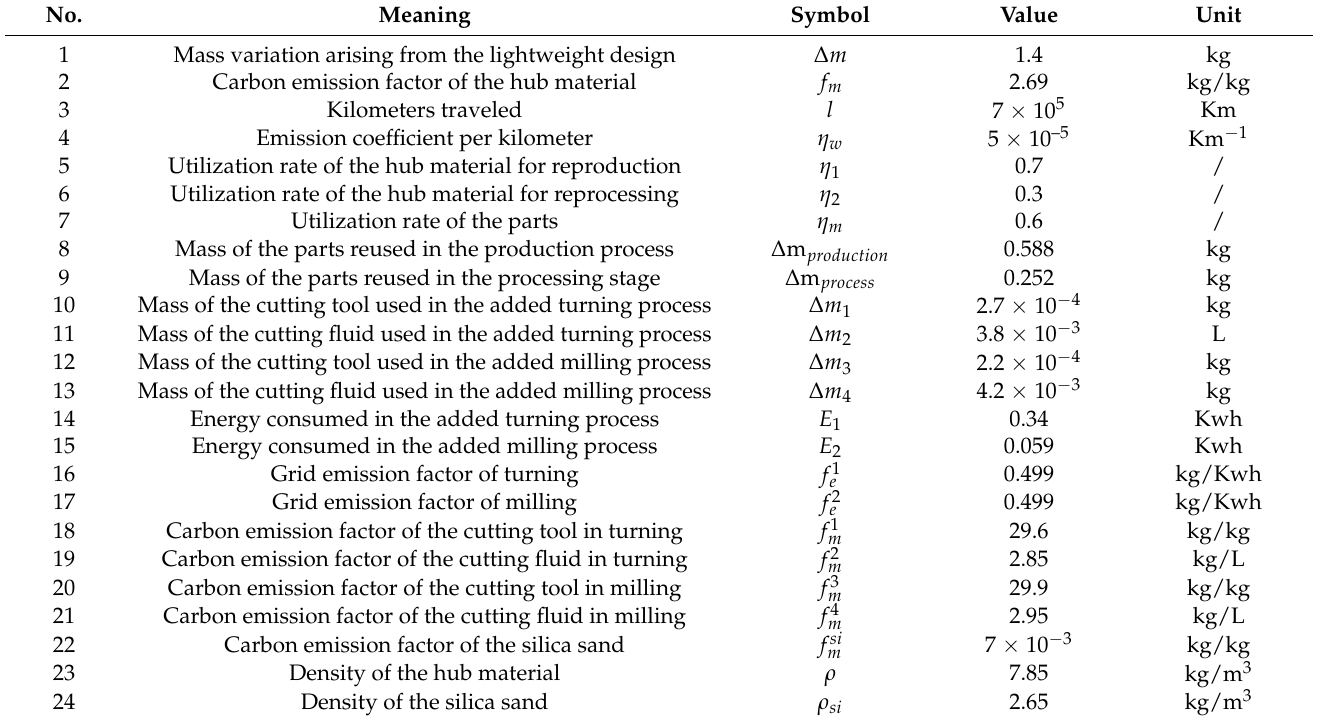
Table 3. Meanings and values of the symbols